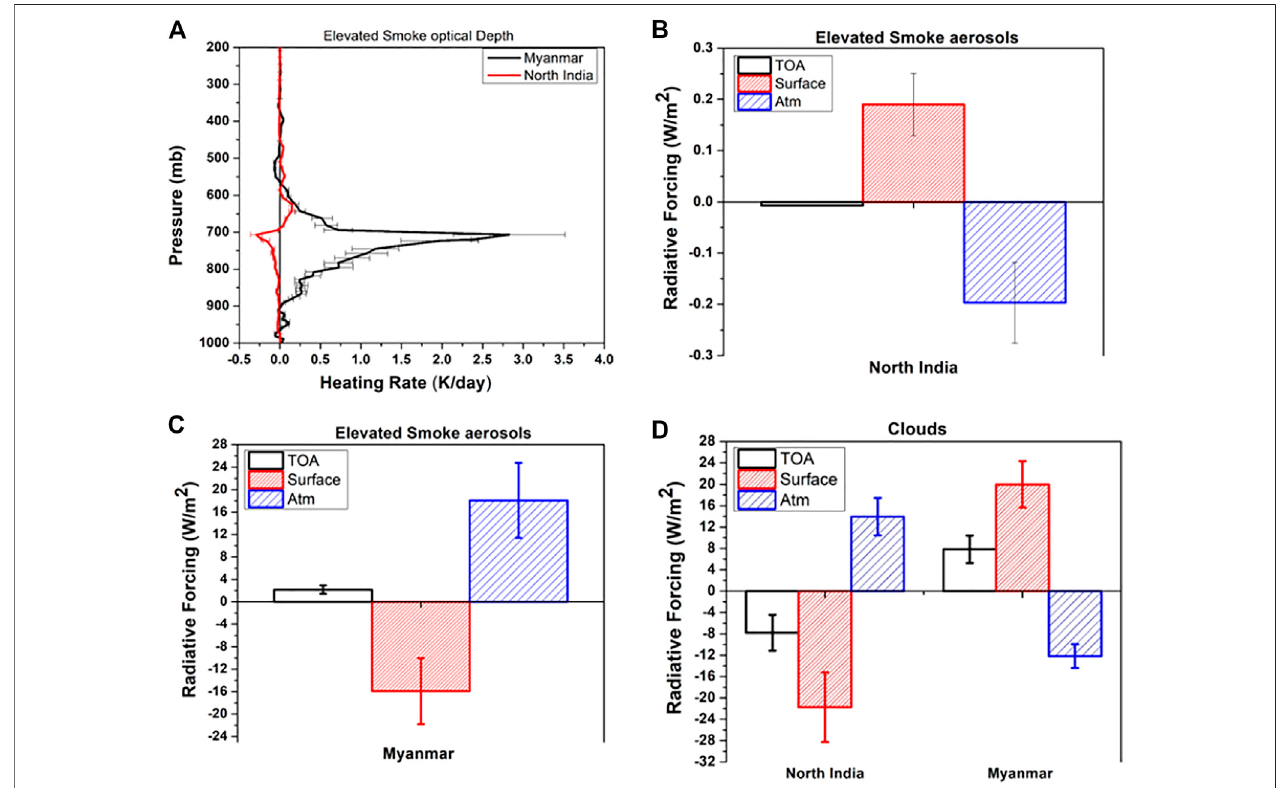
FIGURE 6 | (A) Anomaly of heating rate pro fi le for elevated smoke optical depth-averaged for the period of April-May for the two regions. (B) Radiative forcing due to the elevated smoke aerosols at the top of atmosphere (TOA), atmosphere(ATM), and surface for North Indian region. (C) Radiativeforcingdueto theelevated smoke aerosolsatthetopofatmosphere(TOA),atmosphere(ATM),andsurfaceforMyanmarregion (D) RadiativeforcingduetothecloudsattheTOA,ATM,andsurfaceforthe two regions North India and